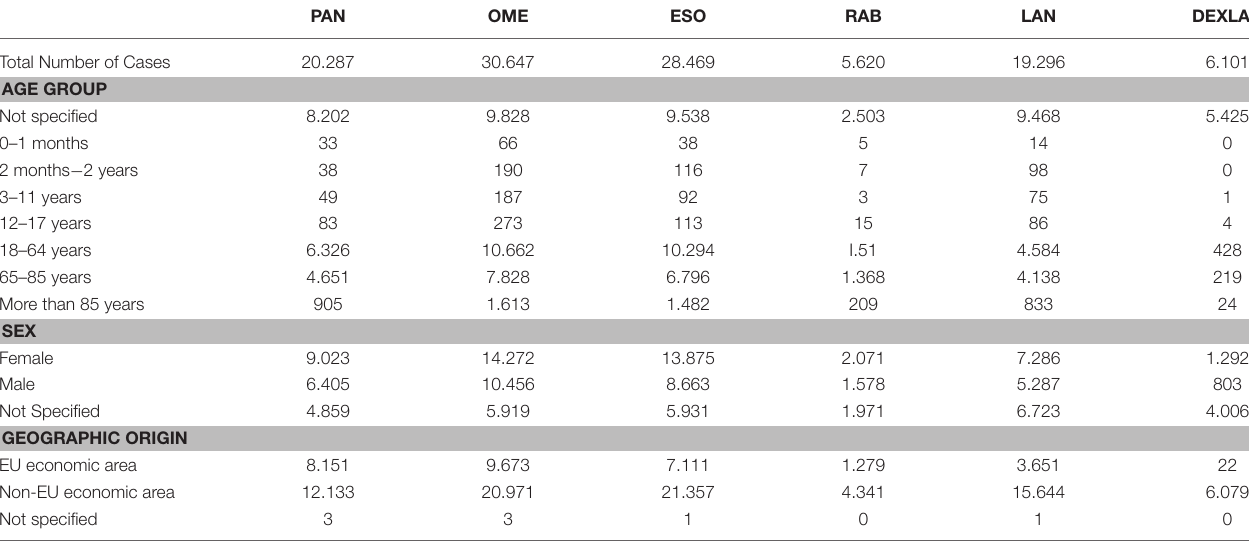
TABLE 3 | Basic analysis of adverse drug (sorted according to a total number of reports, age group, sex, geographic region). PAN OME ESO RAB